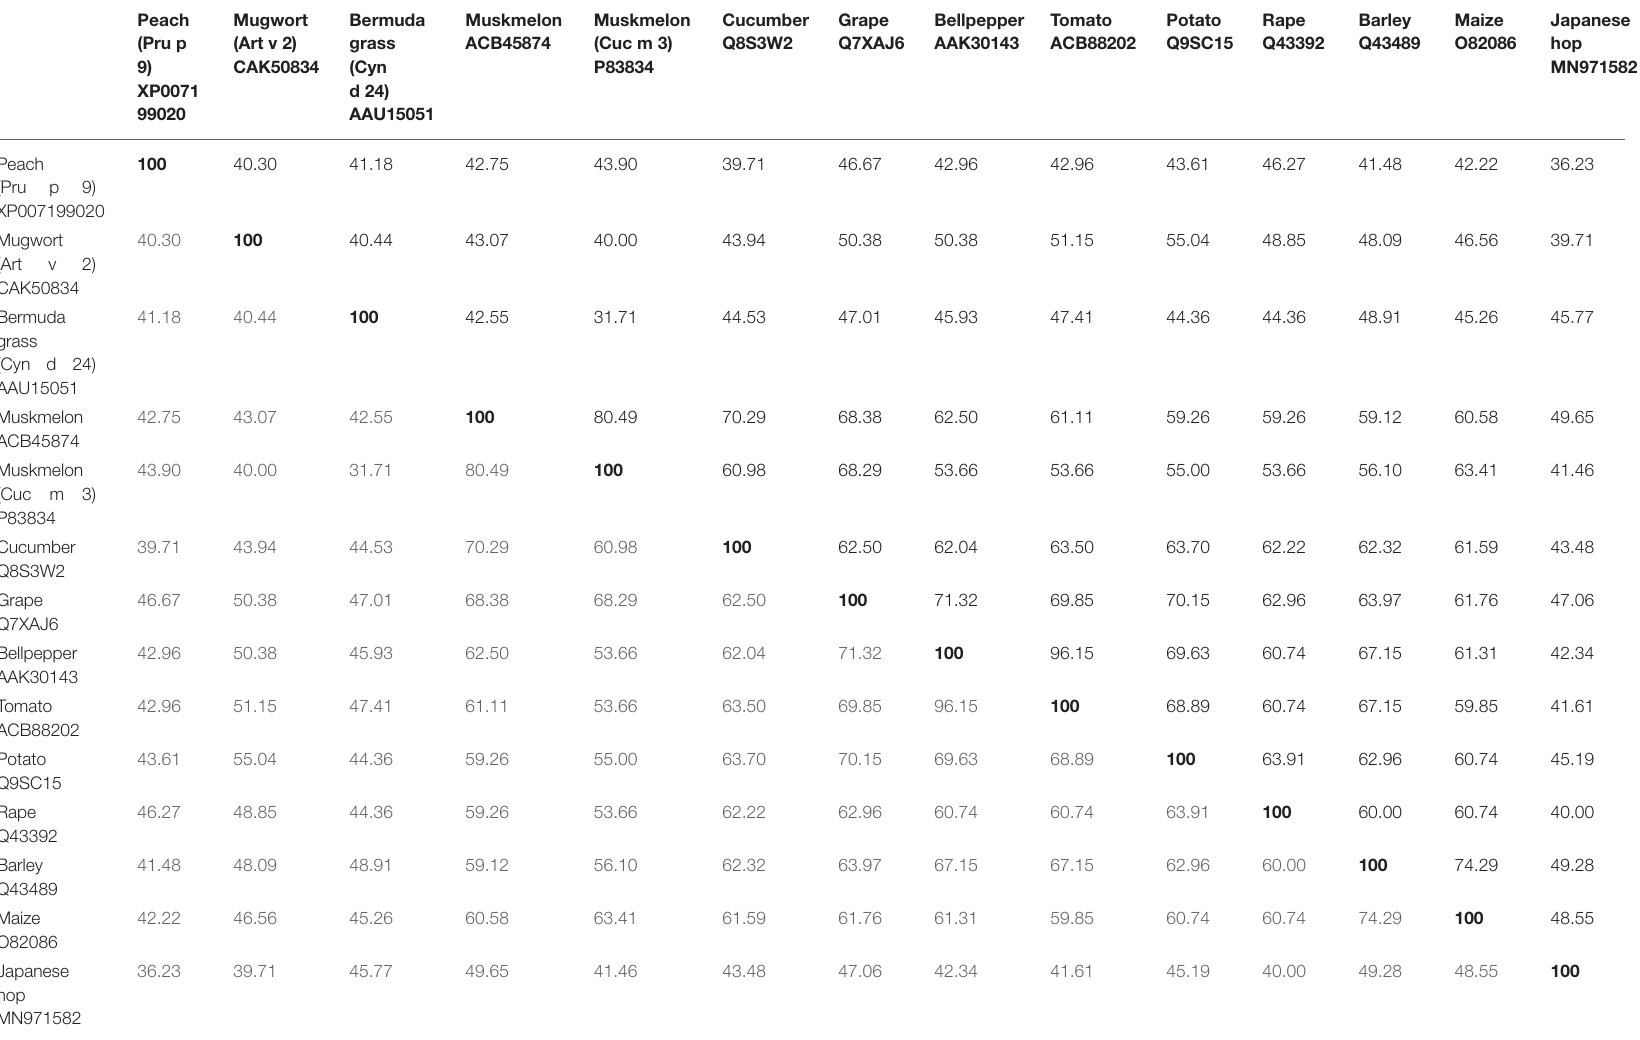
TABLE 1 | AA-identities of Pru p 9, Art v 2, Cyn d 24 and Cuc m 3, including the full length sequence of a Cuc m PR-1 protein, without including the signal